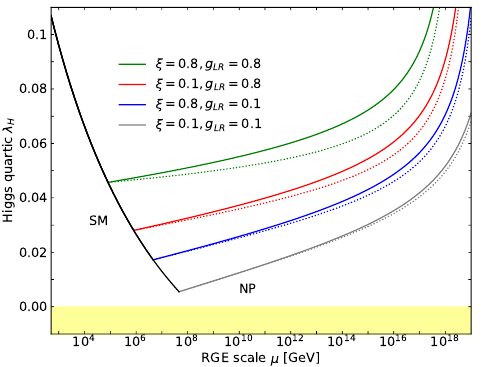
Figure 4 . Evolution of the effective Higgs boson quartic coupling λ H with the renormalization scale µ ∼ H in the framework of Scenario S1 (solid lines) and in its LW extension (dotted lines) for the choice of parameters indicated in the